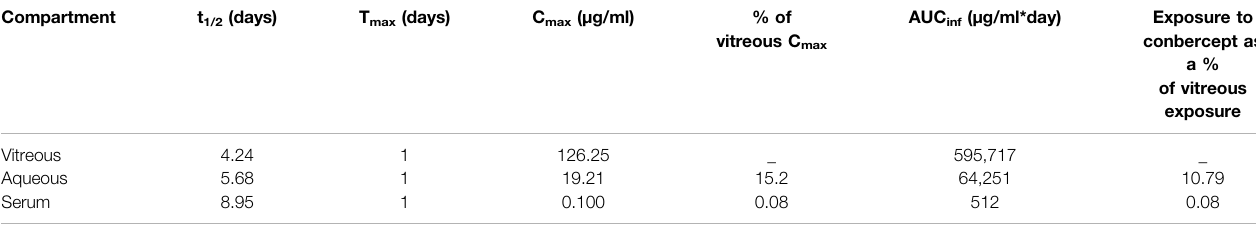
TABLE 1 | Concentration of conbercept in the vitreous, aqueous, and serum after intravitreal injection of 0.5 mg conbercept. Compartment